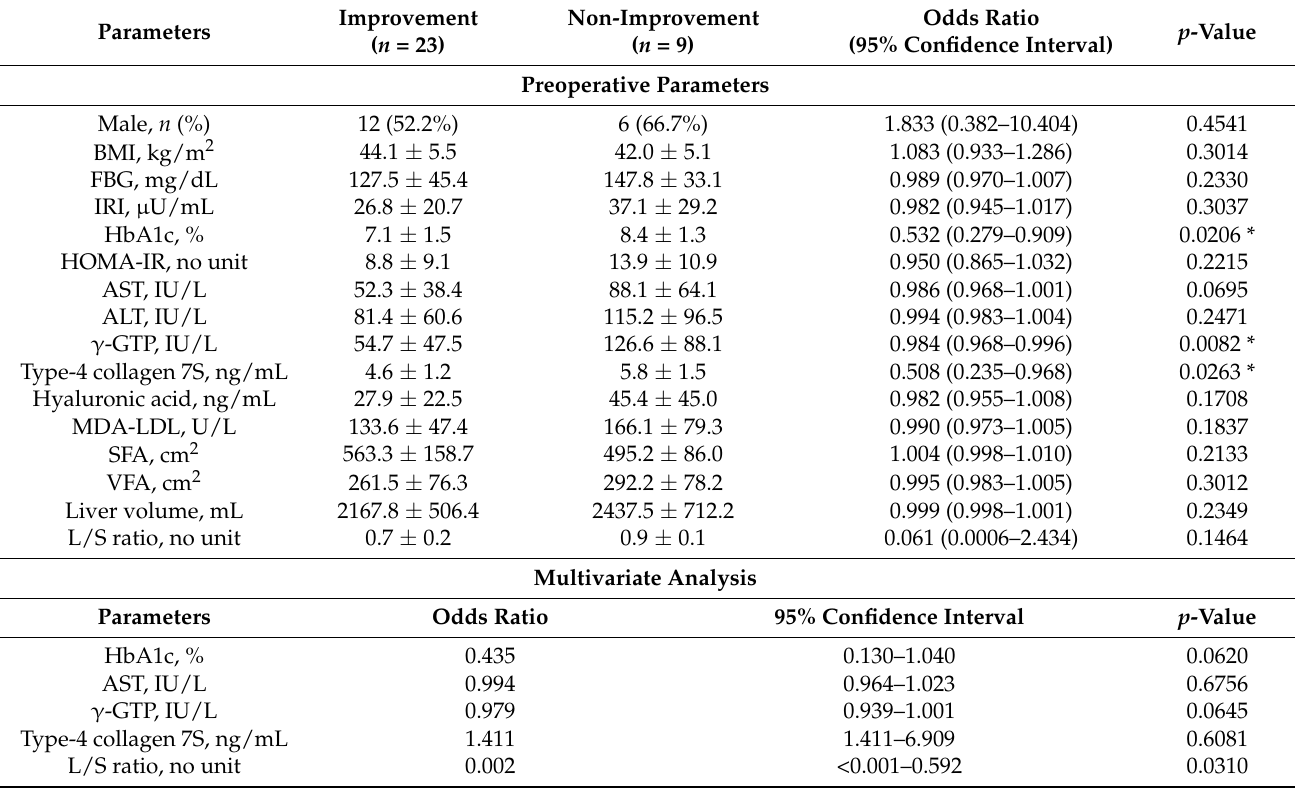
Table 3. Univariate and multivariate analyses of prognostic factors for improvement of NASH at 12 months after